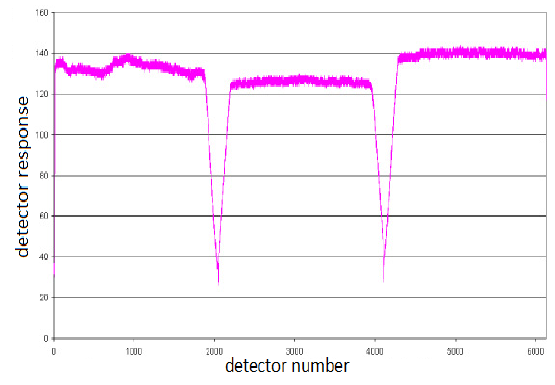
Figure 2. Response of the detectors on three arrays in band